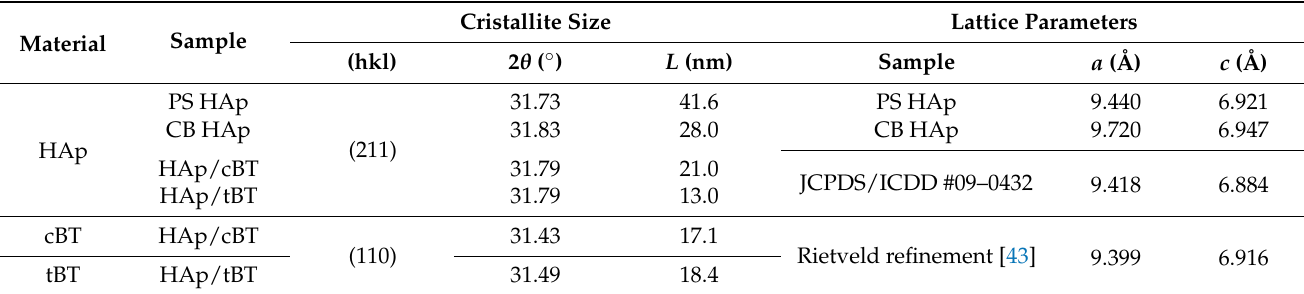
Table 3. XRD results for crystallite size and lattice